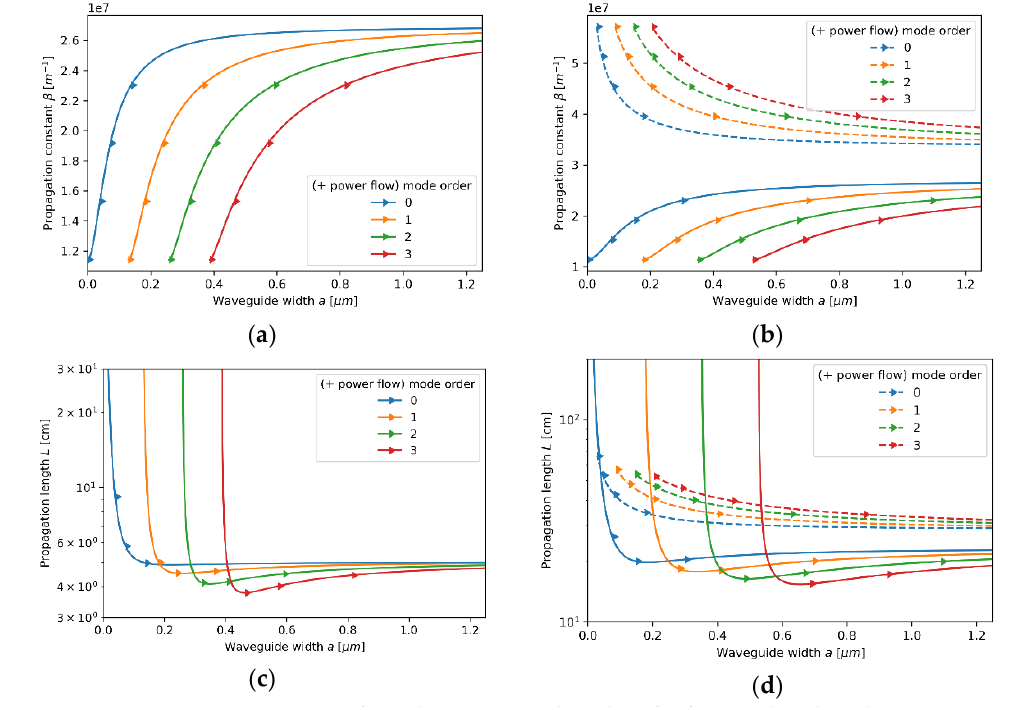
Figure 6. Propagation constant ( a , b ) and propagation length ( c , d ) of TE modes plotted versus wave- guide width for an HMM waveguide with Nb2O5 layer of t Nb2O5 = 80 nm thickness embedded in the unit cell and described with local ( a , c ) and nonlocal EMT ( b , d